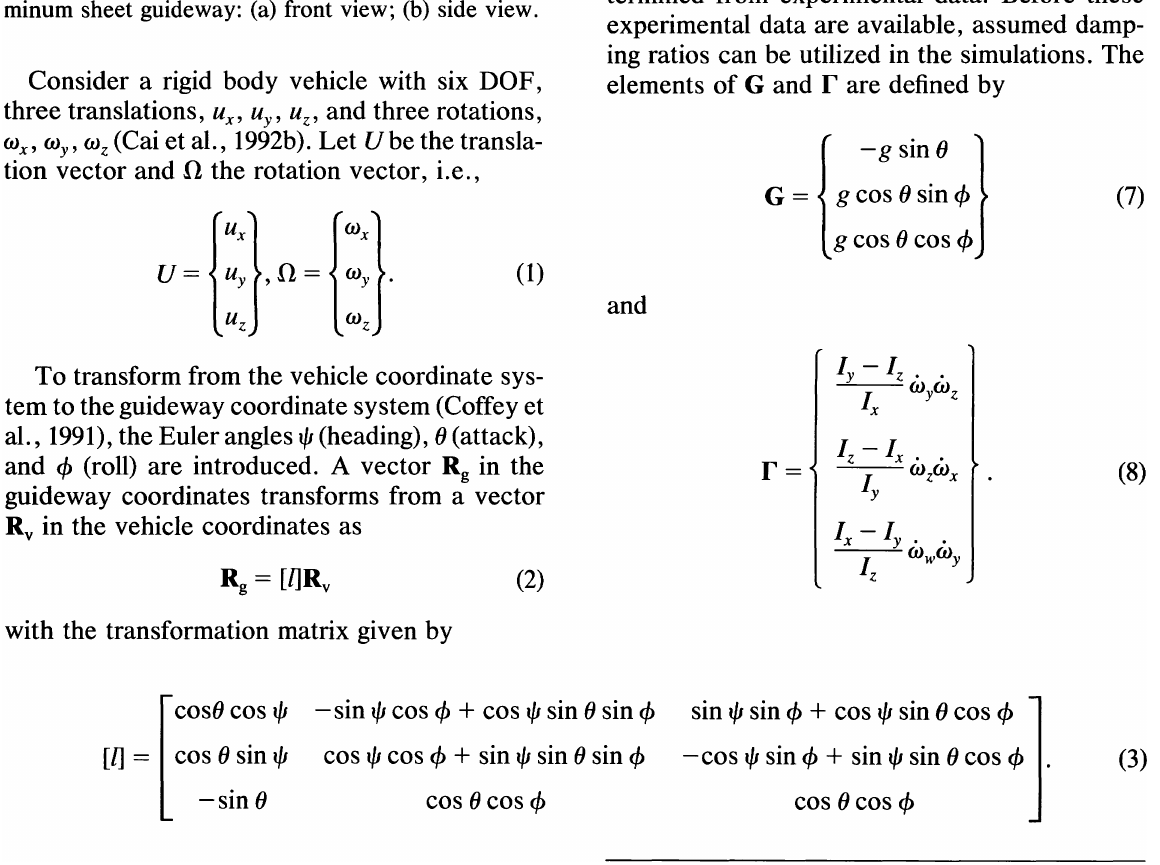
FIGURE 8 Maglev vehicle on double L-shaped alu minum sheet guideway: (a) front view; (b) side